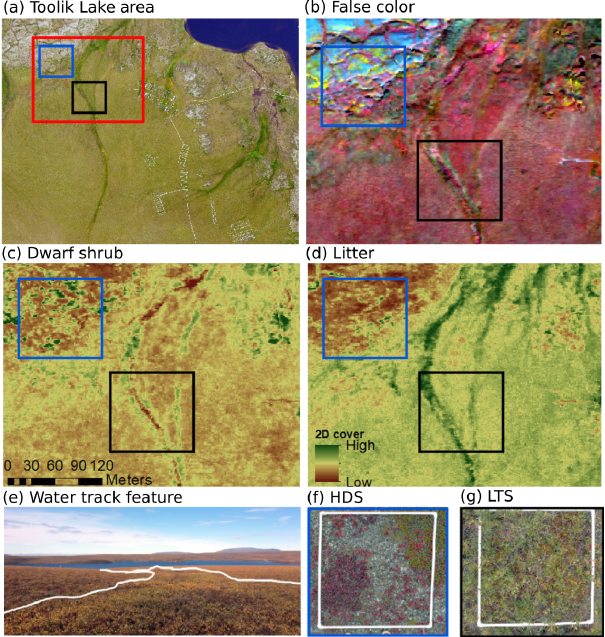
Figure 19. (a) A 50cm aerial photograph of the Toolik vegeta- tion grid (Toolik Lake Environmental Data Centre, https://toolik. alaska.edu/edc/, 2017); the inset represents the extent of hyperspec- tral imagery below. (b) A false color composite of the northwest corner of the study area – R : 812, G : 686, B : 546nm. (c) Dwarf shrub 2D cover estimated by NRI λ 1 : 550 and λ 2 : 650nm. (d) Lit- ter 2D cover estimated by NRI λ 1 : 525 and λ 2 : 600nm. (e) Field photo of a water track feature from the study area. (f) Hemiprostrate and prostrate dwarf shrub, forb, moss, and fruticose–lichen tundra. (g) Low and tall shrublands (Beamish et al., 2020). The airborne image is provided by the Toolik Lake Environmental Data Centre© (https://toolik.alaska.edu/edc/, last access: 11 January 2016).